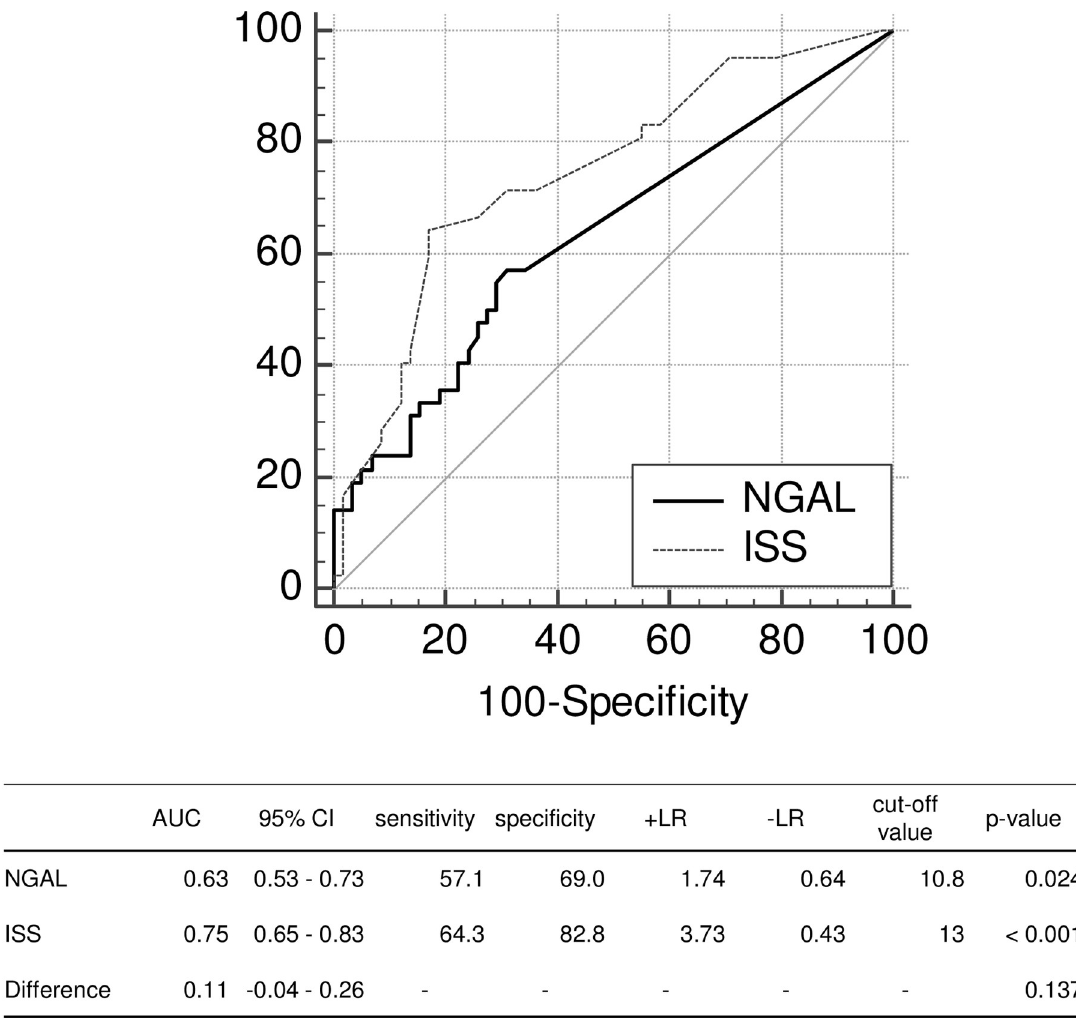
Fig 2. Comparison of the areas under the curve between NGAL levels and ISS on ECU stay. AUC: area under the curve; +LR: positive likelihood ratio; -LR: negative likelihood ratio; NGAL: neutrophil gelatinase-associated lipocalin; ISS: Injury Severity Score; ECU: Emergency Care